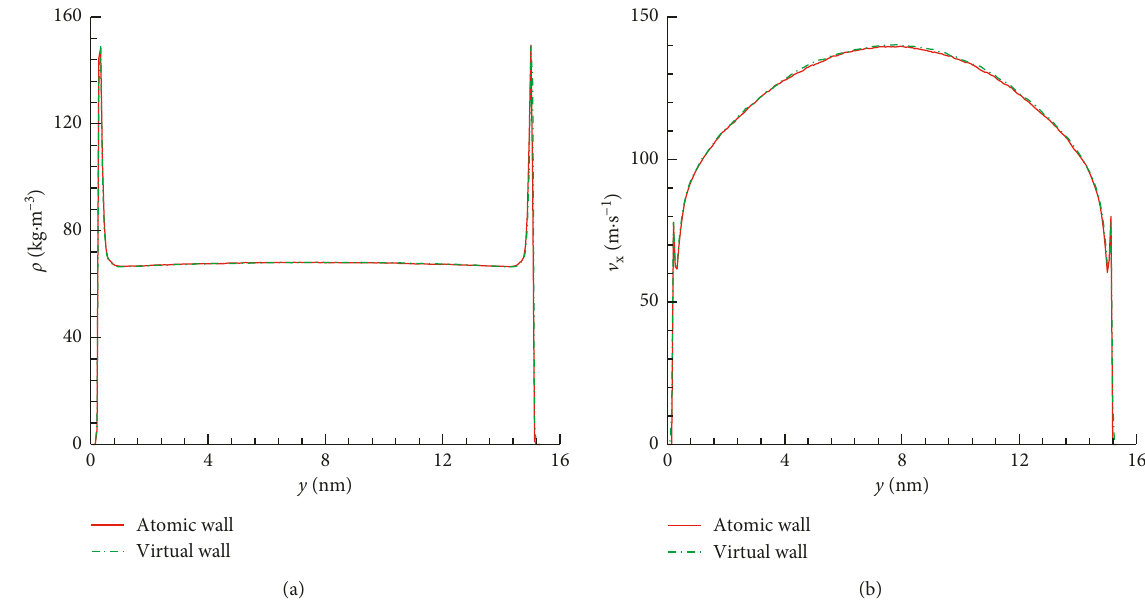
Figure 1: Comparisons between the atomic- and virtual-wall models for the smooth wall: (a) density profile; (b) velocity profile.